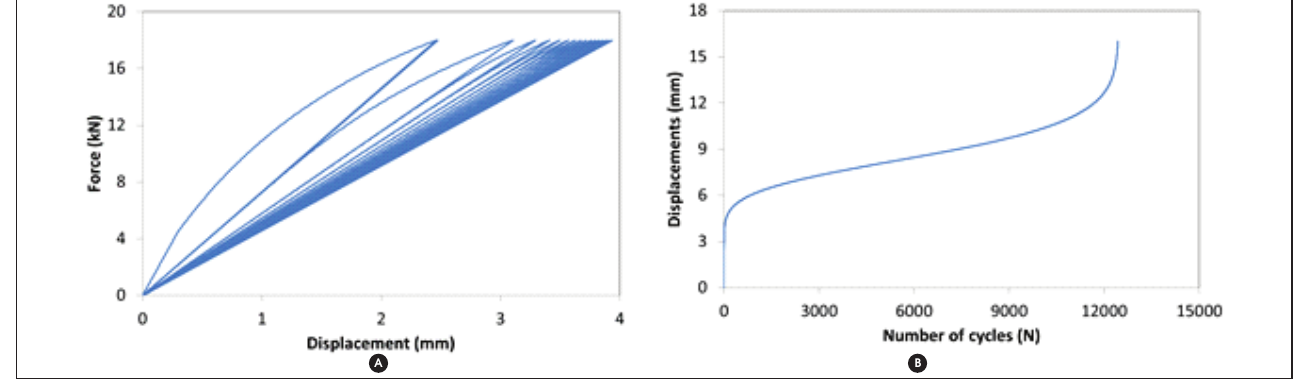
Figure 11 – Results obtained by proposed numerical model for reinforced concrete beam subjected to vertical cyclic loads: a) Load vs. Deflection; b) Deflection evolution with increasing number of cycles